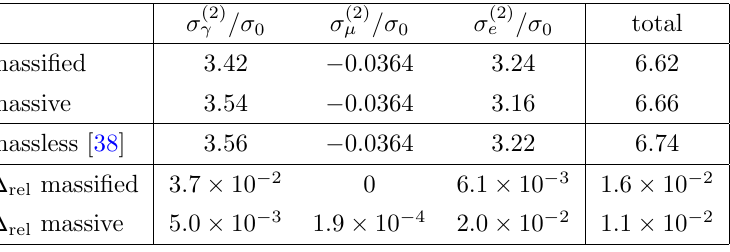
Table 1 . The di(cid:11)erent contributions to (cid:27) (2) . Note that (cid:27) (2) e also includes the process (cid:22) ! (cid:23) (cid:22) (cid:23)e ee . See text for interpretation. The coupling (cid:22) (cid:11) ( (cid:22) = M ) is renormalised in the MS scheme. (cid:1) rel denotes the relative di(cid:11)erence of our results to the massless result [38].